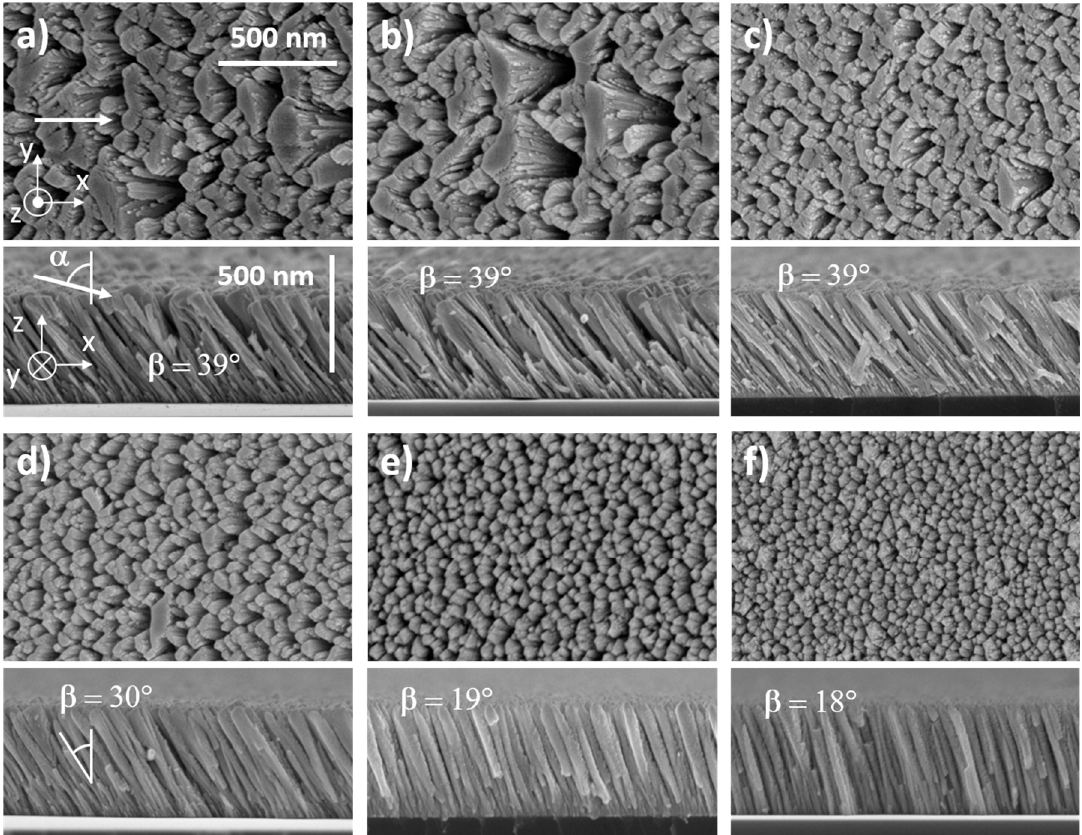
Figure 6. Top and cross-section observations by SEM of W films sputter-deposited with a substrate angle α = 80°. The deposition time was set to get a constant film thickness of 400 nm. White arrows indicate the direction of incoming particle flux. Column angle β changed from 39° ± 2° to 18° ± 2° as the argon sputtering pressure increased from 2.5 × 10 − 3 to 15 × 10 − 3 mbar: ( a ) 2.5; ( b ) 3.5; ( c ) 4.0; ( d ) 6.0; ( e ) 10, and ( f ) 15 × 10 − 3 mbar.